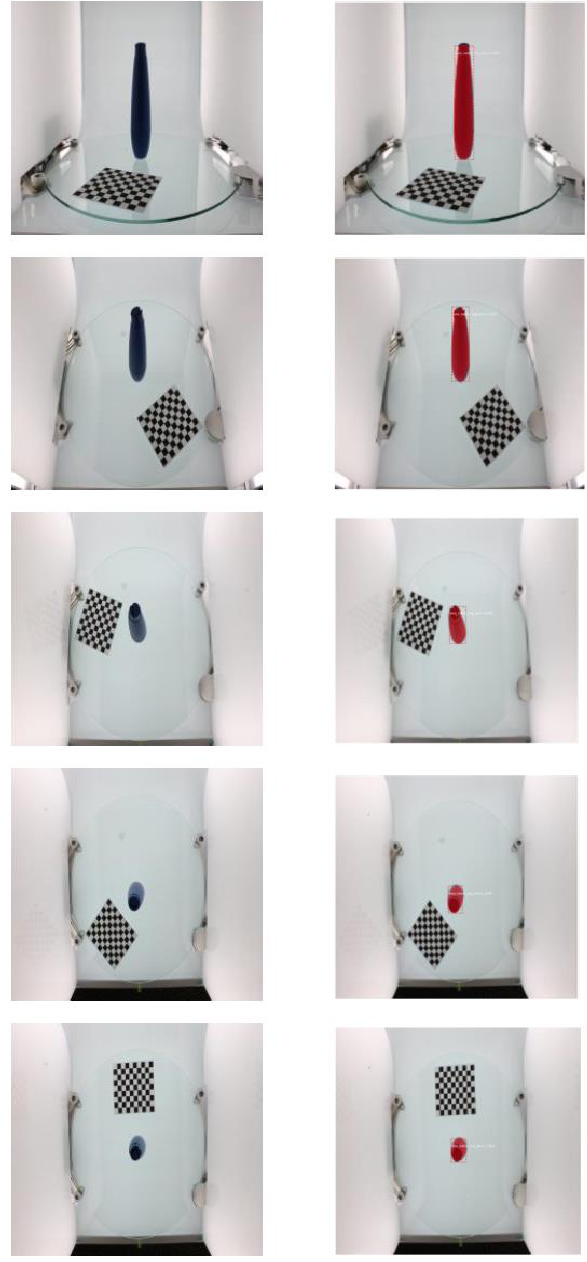
Figure 12. Results for ikea_table_leg_blue data using the Mask R-CNN-based object detection method. The column on the left contains the input images. The column on the right shows the positioning and segmentation